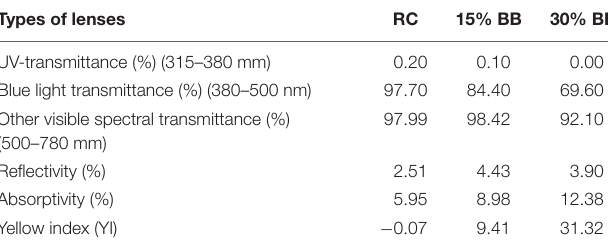
TABLE 1 | Optical detection parameters of three types of